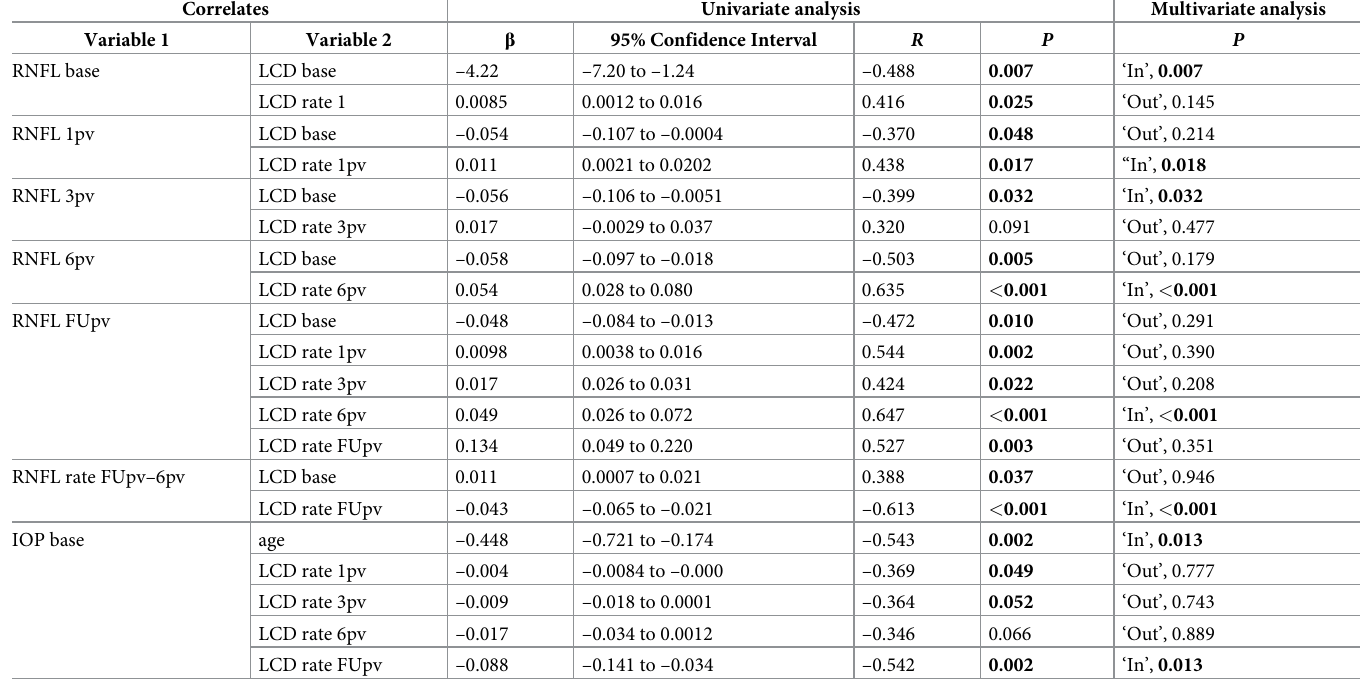
Table 3. Results of univariate and multivariate linear regression analyses to determine factors associated with the IOP reduction, change in the LCD and RNFL thickness. Listed are only those variables that achieved univariate correlation at the significance level of � 0.1.